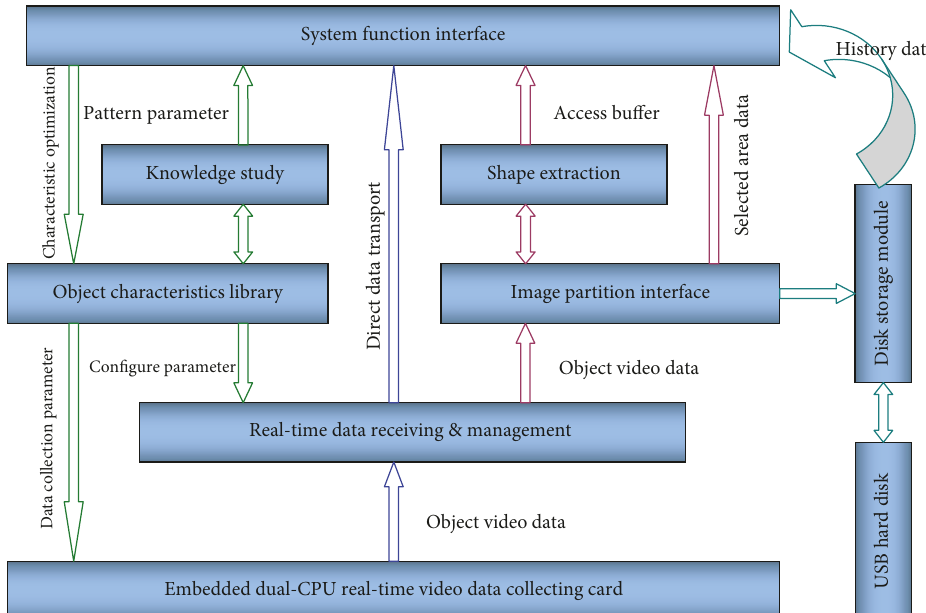
Figure 7: Module composition and data interaction of the cognition software.